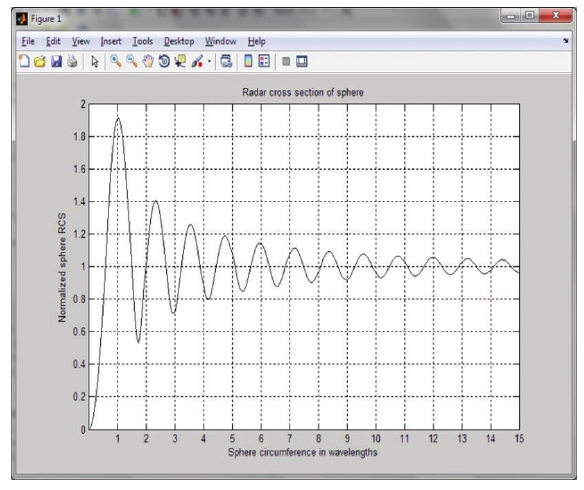
Figure 14: RCS of